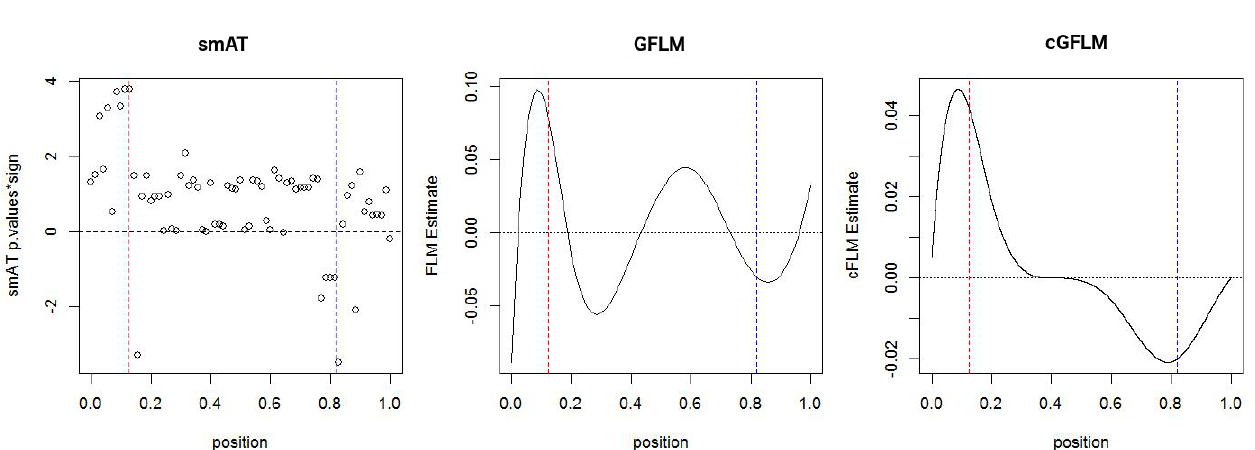
Figure 3. Illustration of fitted genetic mapping patterns using different models. A modified Manhattan plot of the − log10 ( p -values) by the sign of the fitted coefficients is used for smAT. For all other methods, the coefficient estimates are plotted. The causal loci is highlighted with dashed lines (left in red for positive effect, right in blue for negative